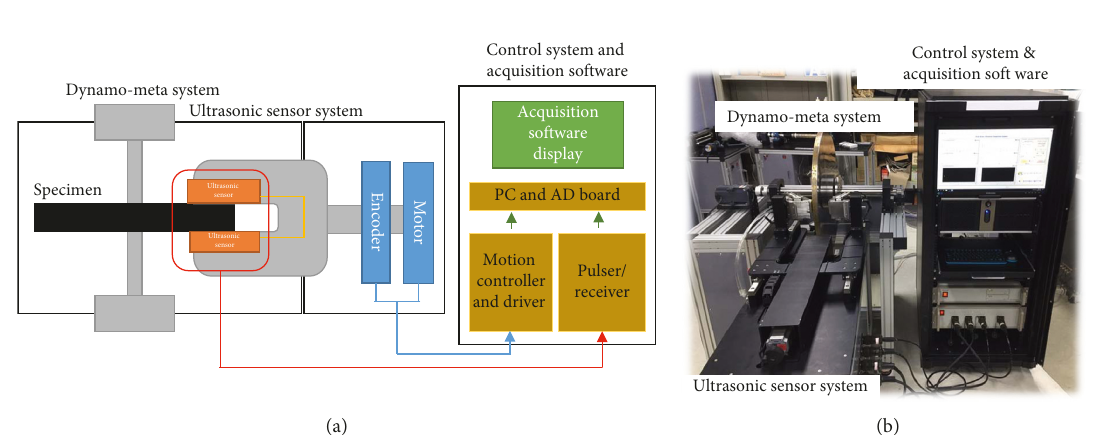
Figure 6: (a) Schematic diagram and (b) photo of the KTX brake disc inspection